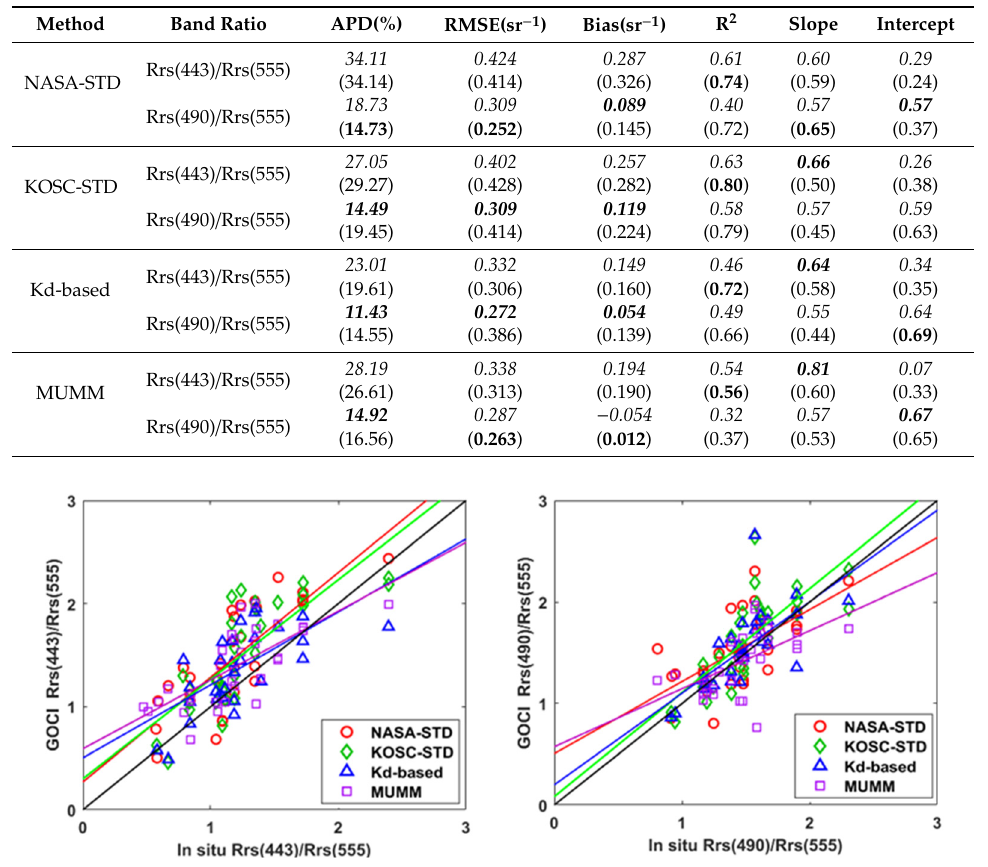
Table 5. Statistical results for the retrieved values of two band ratios, Rrs(443)/Rrs(555) and Rrs(490)/Rrs(555), obtained using the NASA-STD, the KOSC-STD, the Kd-based, and the MUMM algorithms. The italic numerals of each index represent ±3 h, while the statistical results in parentheses are ±1 h.